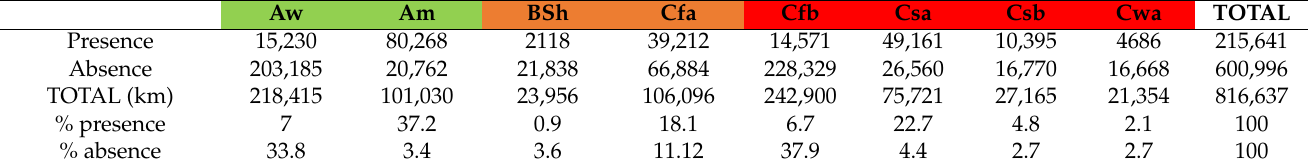
Table 4. Potential area of presence/absence (km 2 ) and percentage of presence/absence relative to the global potential species distribution area for all Köppen–Geiger climatic regions. In green, native area; in orange, native and non-native area; in red, non-native